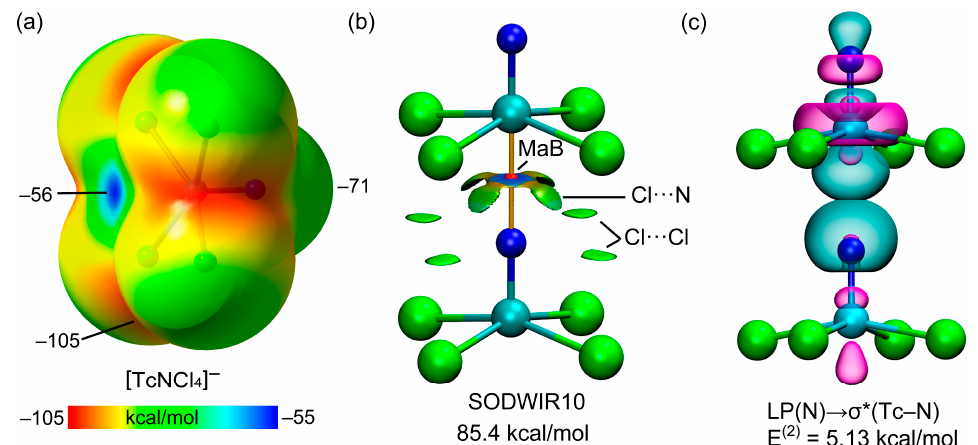
Figure 4. ( a ) MEP surface of [TcNCl 4 ] – (isosurface 0.001 a.u.). Energies at selected points in kcal/mol. ( b ) QTAIM/NCIPlot analysis of the dimer of SODWIR10 with indication of the dimerization energy. ( c ) Plot of the NBOs involved in the donor–acceptor interaction with indication of the E (2) energy. Color code: Chlorine green, Nitrogen blue, Technetium teal.